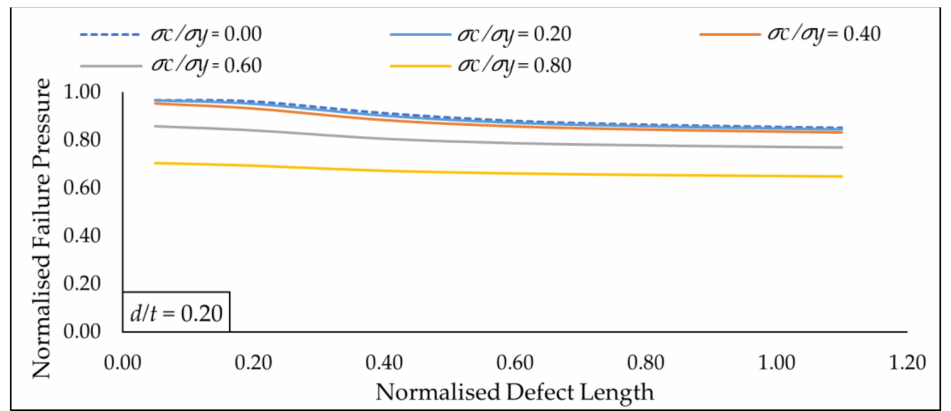
Figure 16. Normalized failure pressure predictions of the new assessment method against various normalized defect length for multiple axial compressive stress at a constant normalized defect depth of 0.20.